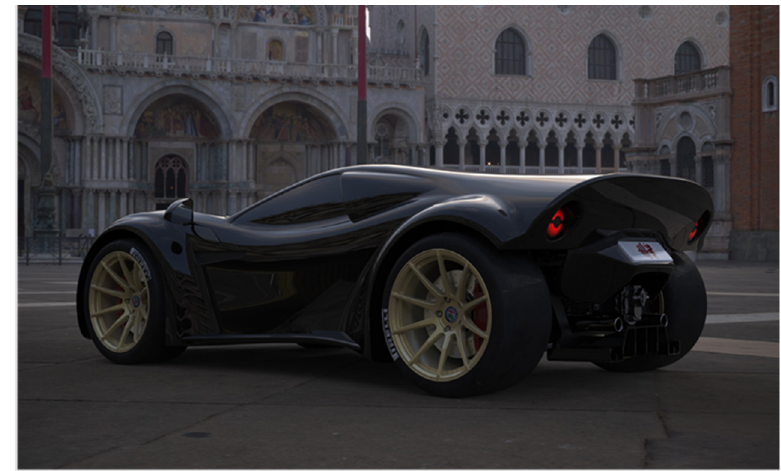
Figure 36. Natural concept rendering.